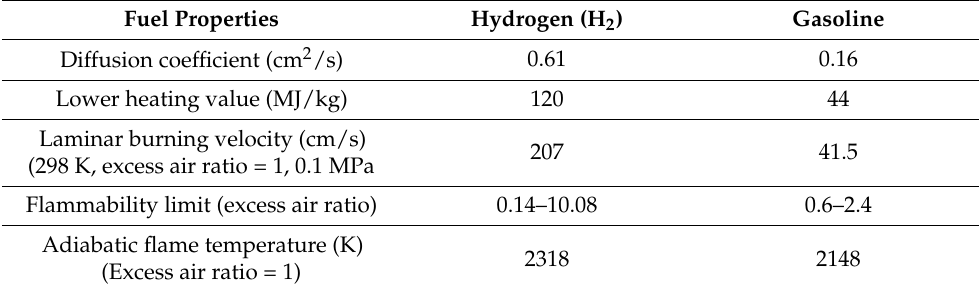
Table 1. Fuel properties. Reproduced with permission from Li, G., etc., Int. J. Hydrog. Energy; published by Elsevier, 2019